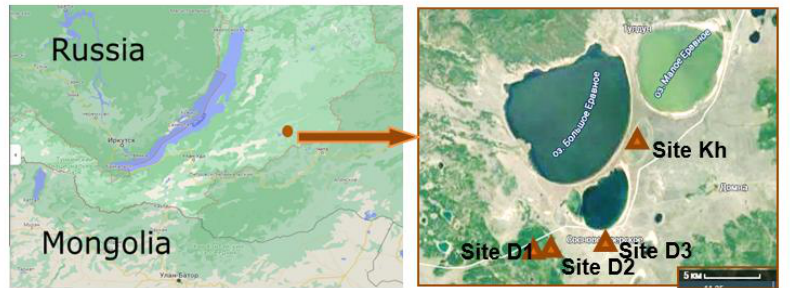
Table 1 provides a summary of sampling locations.